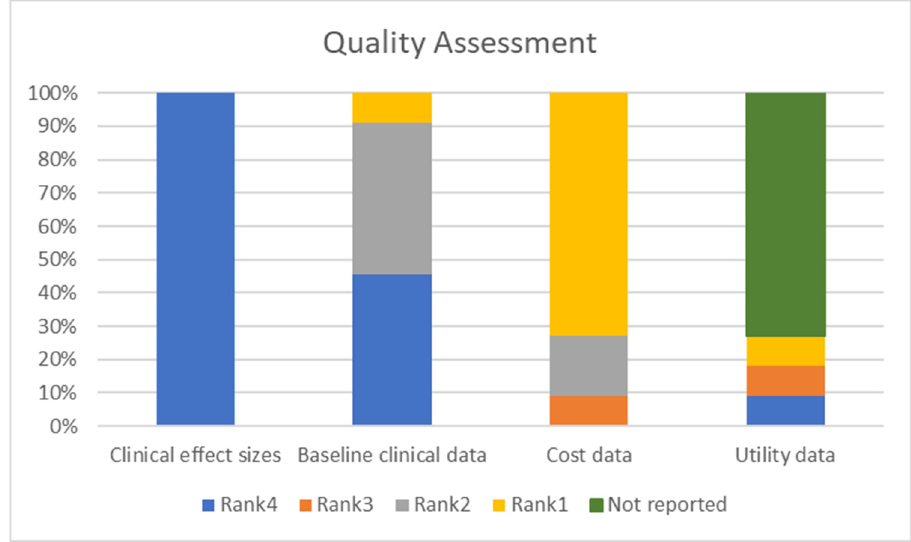
Figure 4. Quality assessment of evidence used in economic evaluation studies. Y ‐ axis represents a rank based on the quality assessment (%). X ‐ axis represents for data components.